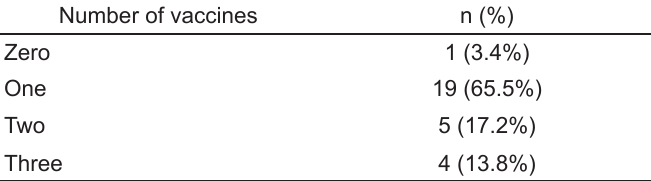
Table 4. Number of vaccines received by patients with suspected rabies